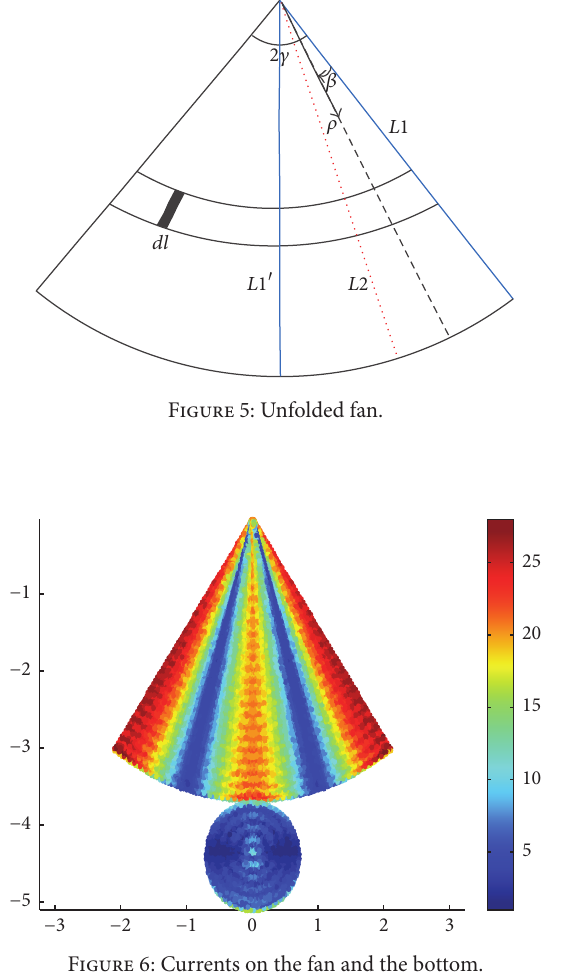
Figure 6: Currents on the fan and the